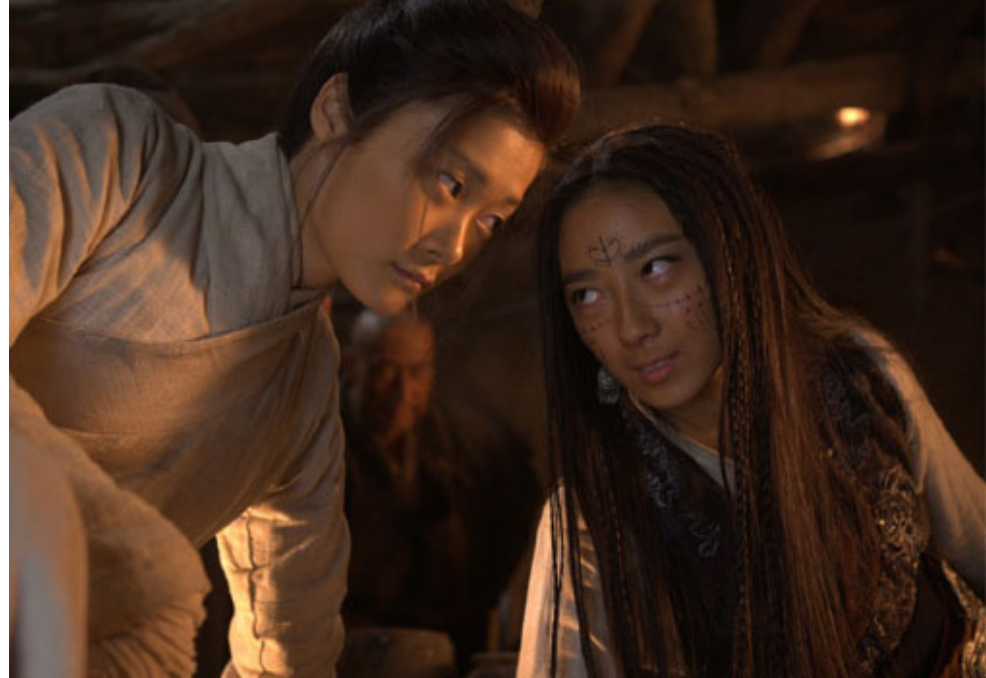
Figure 2. Originally rivals, Gu Shaotang and Burudu decide to steal the hidden gold together.